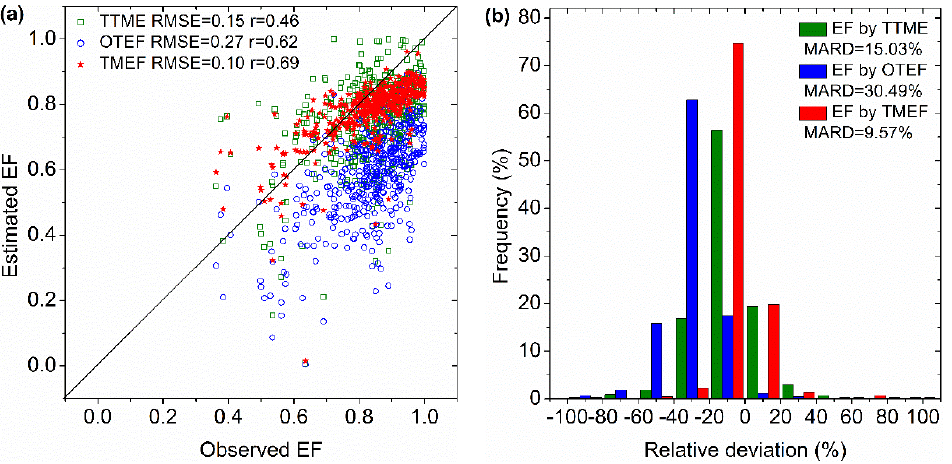
Figure 3. Comparison of the estimated EF with observed EF at all stations in ( a ) scatter plot and ( b ) frequency histogram of the relative deviation.